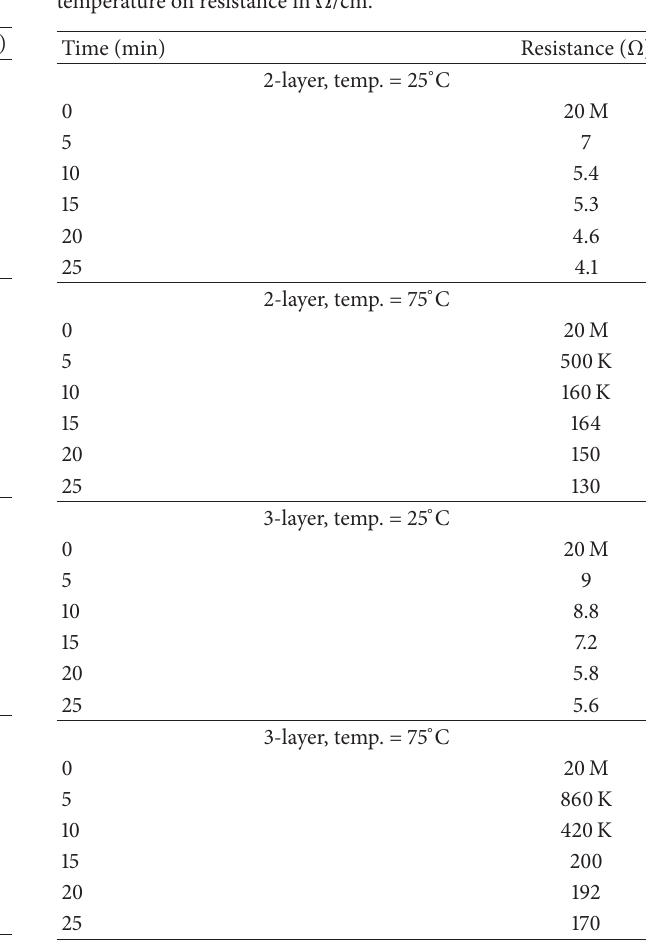
Table 2: Effect of 2-layer and 3-layer printing under exposure to temperature on resistance in Ω